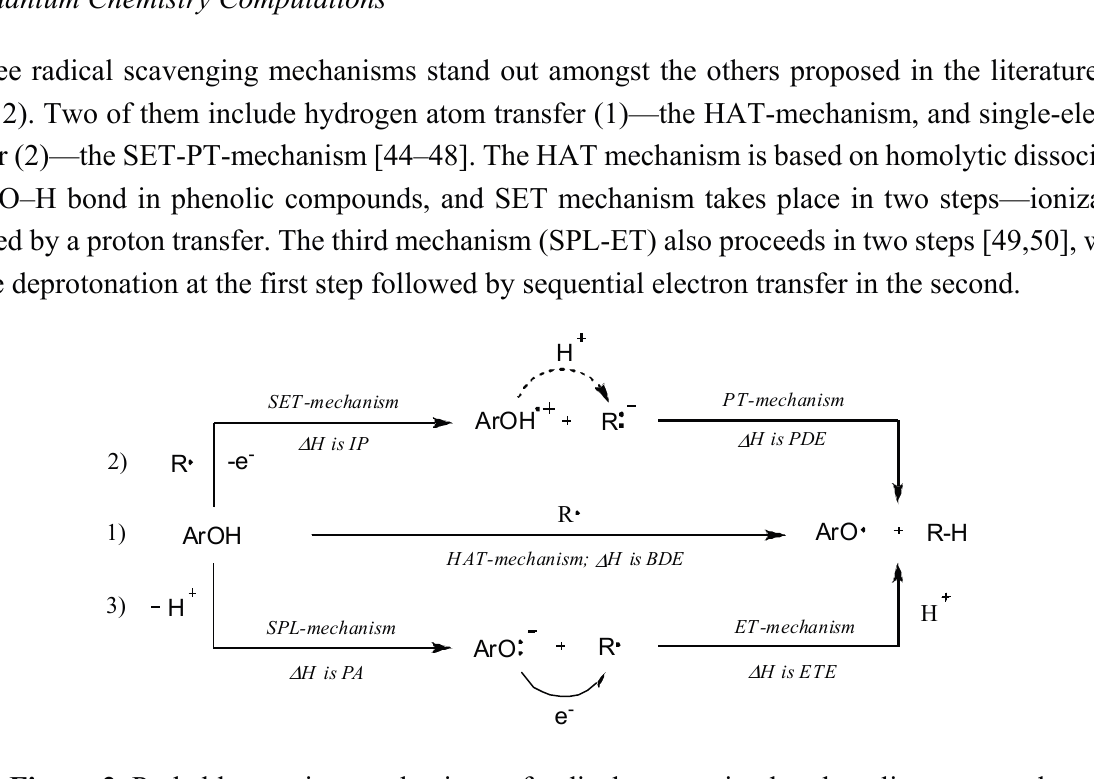
Figure 2. Probable reaction mechanisms of radical scavenging by phenolic